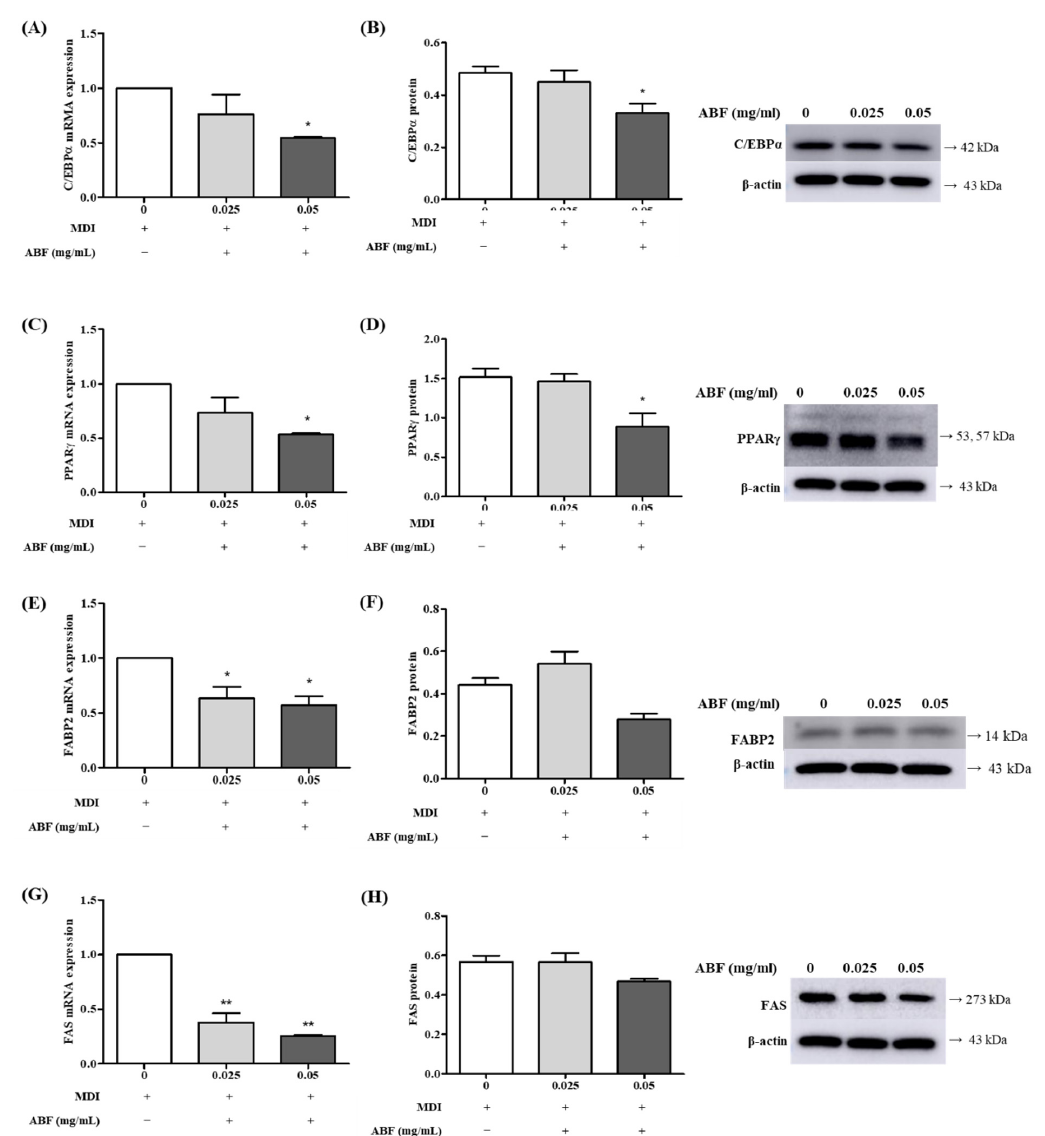
Figure 7. Effects of adipogenesis levels on the Aronia bioactive fraction (ABF ® ) in 3T3-L1 adipocytes. 3T3-1 adipocytes were treated with ABF ® (0.025 and 0.05 mg/mL). ( A , B ) RT-qPCR and Western blot measured mRNA and protein expression of C/EBP α . ABF ® (0.05 mg/mL) significantly reduced C/EBP α levels in 3T3-L1 adipocytes. ( C , D ) RT-qPCR and Western blot measured mRNA and protein expression of PPAR γ . ABF ® (0.05 mg/mL) significantly reduced PPAR γ levels in 3T3-L1 adipocytes. ( E , F ) RT-qPCR and Western blot measured mRNA and protein expression of FABP2. ABF ® (0.05 mg/mL) reduced FABP2 levels in 3T3-L1 adipocytes. ( G , H ) RT-qPCR and Western blot measured mRNA and protein expression of FAS. ABF ® (0.05 mg/mL) significantly reduced FAS levels in 3T3-L1 adipocytes. Data represent the mean ± SEM. * p < 0.05, ** p < 0.001 compared with the MDI control group.